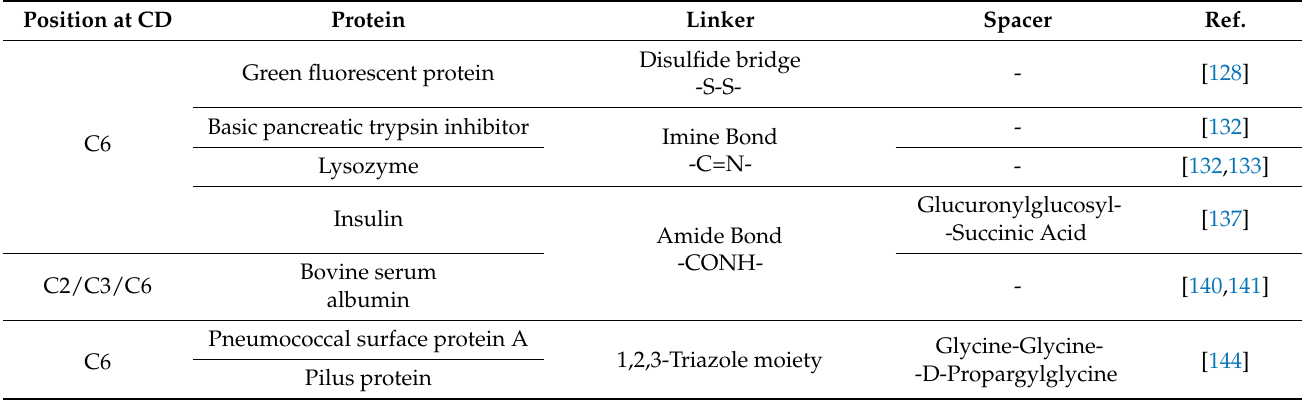
Table 1. Structural characteristic of cyclodextrin-protein